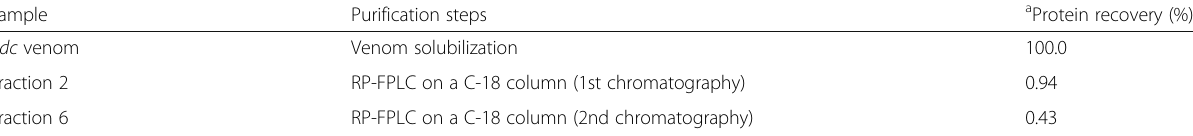
Table 1 Protein recovery (%) during the purification procedure of disintegrin from Crotalus durissus collilineatus venom